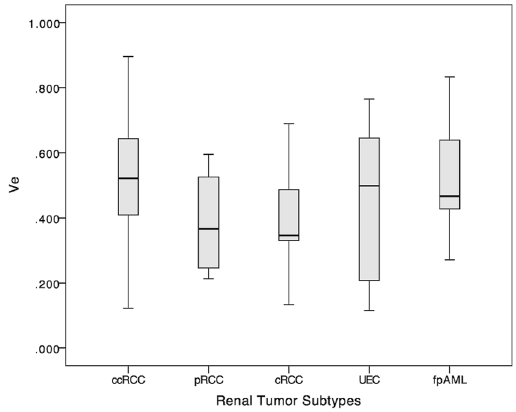
Figure 4. Box-and-whisker plot of V e value. Boxes = interquartile range, whiskers = range of all values, horizontal line within box = median V e , ccRCC = clear cell RCC, pRCC = papillary RCC, cRCC = chromophobic RCC, UEC = uroepithelial carcinoma, fpAML = fat poor